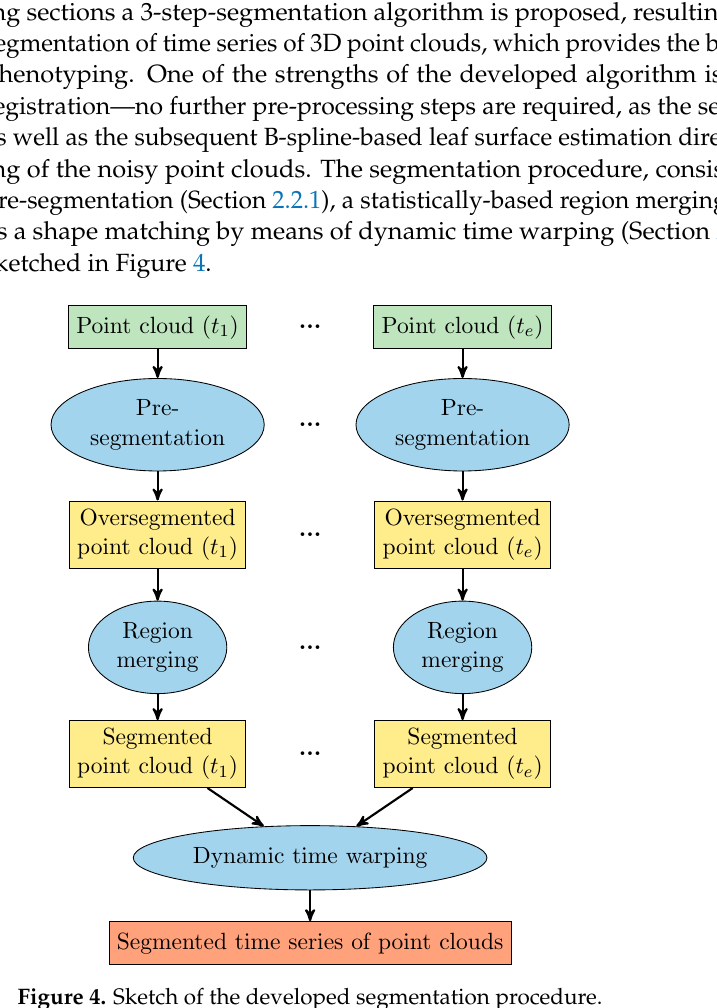
Figure 4. Sketch of the developed segmentation